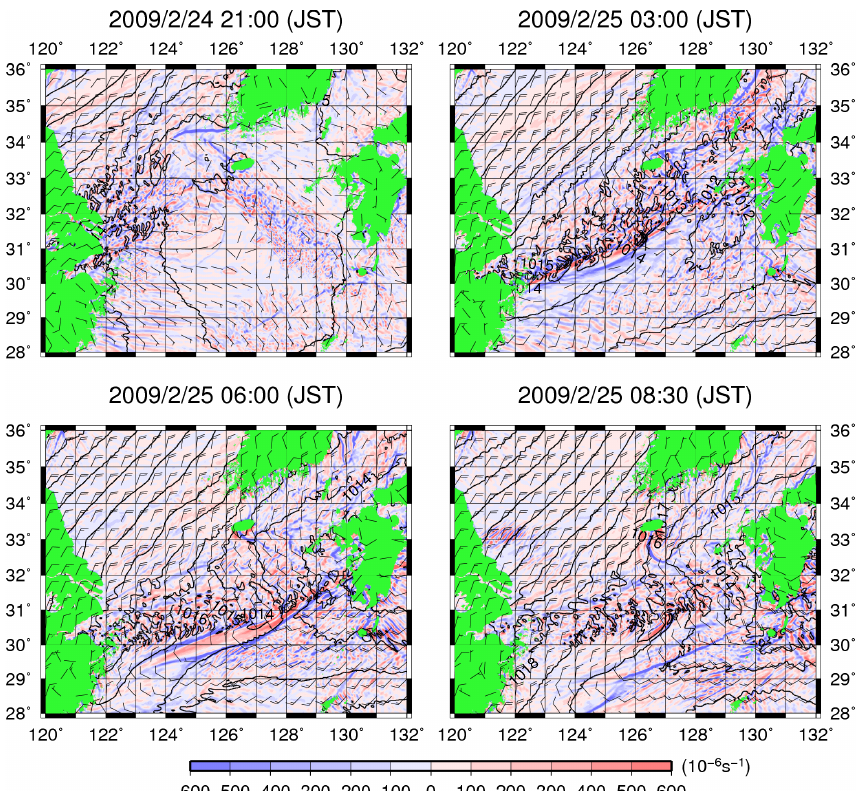
Fig. 13. Computed surface pressure (contour interval: 1hPa) and divergence of the surface 10-m wind (colour scale). Wind barbs indicate 5ms − 1 .